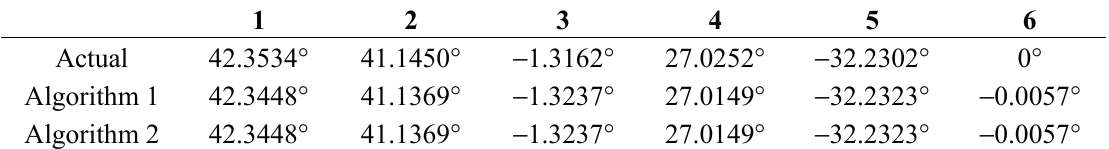
Table 8. Alignment results of the six simulations